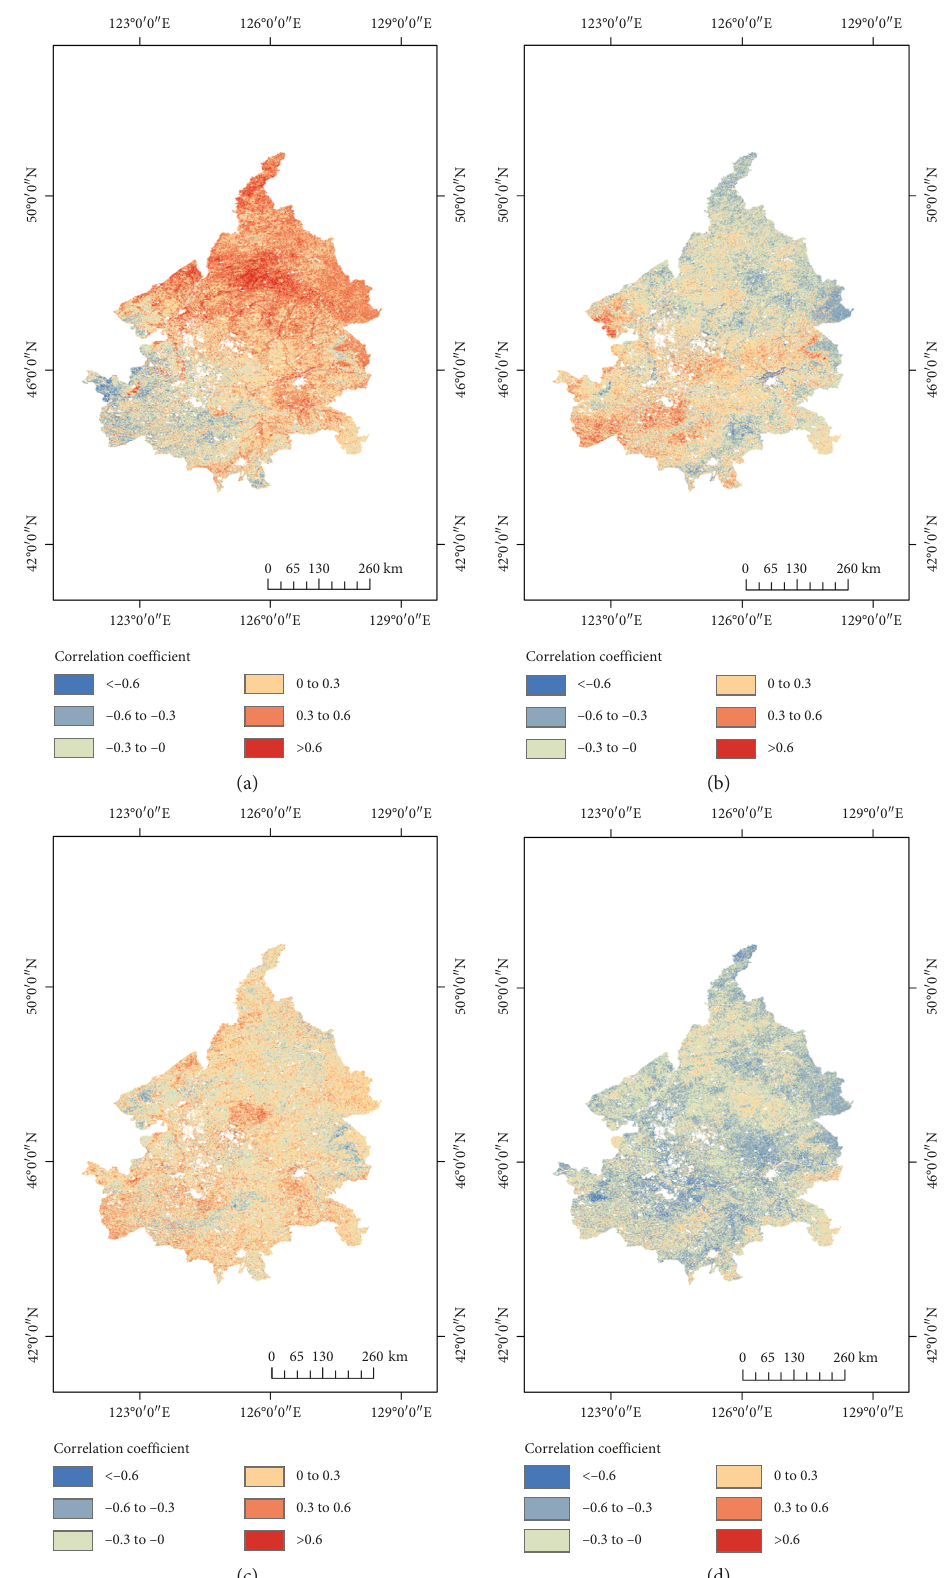
Figure 5: Correlation coefficients between WUE and major climatic factors: (a) annual precipitation, (b) total annual sunshine duration, (c) annual average relative humidity, and (d) annual average